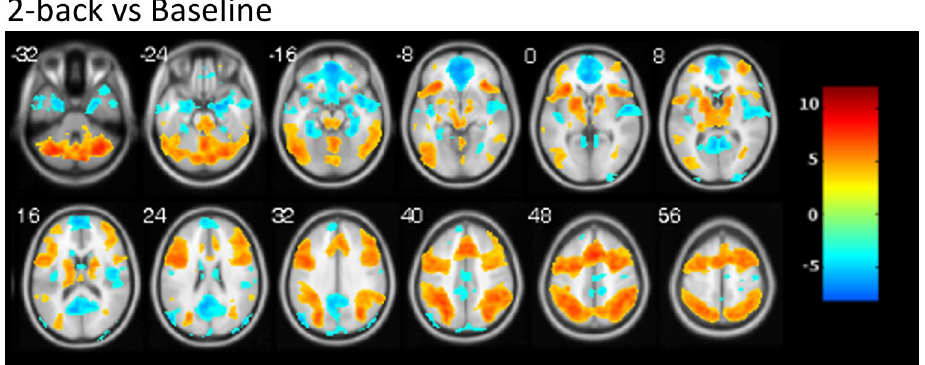
Fig 3. Activation map for the n-back task. Warm colors show activation of the 2-back condition compared to baseline, cold colors show deactivation. Numbers indicate z coordinate in MNI space. Images are displayed in neurological convention (right is right). Color bar depicts Z